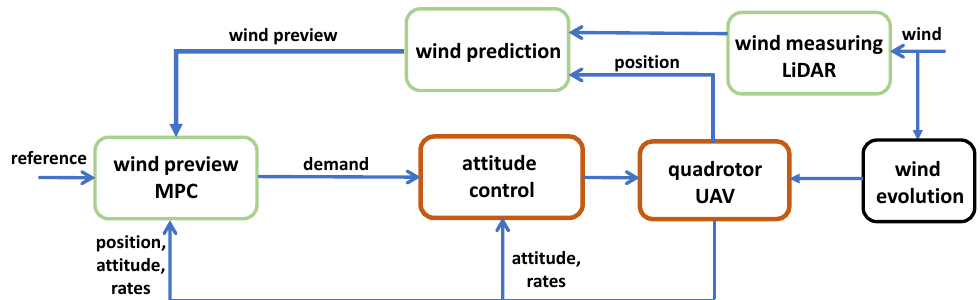
Figure 1. Overall system architecture of the gust rejection control system for the quadrotor